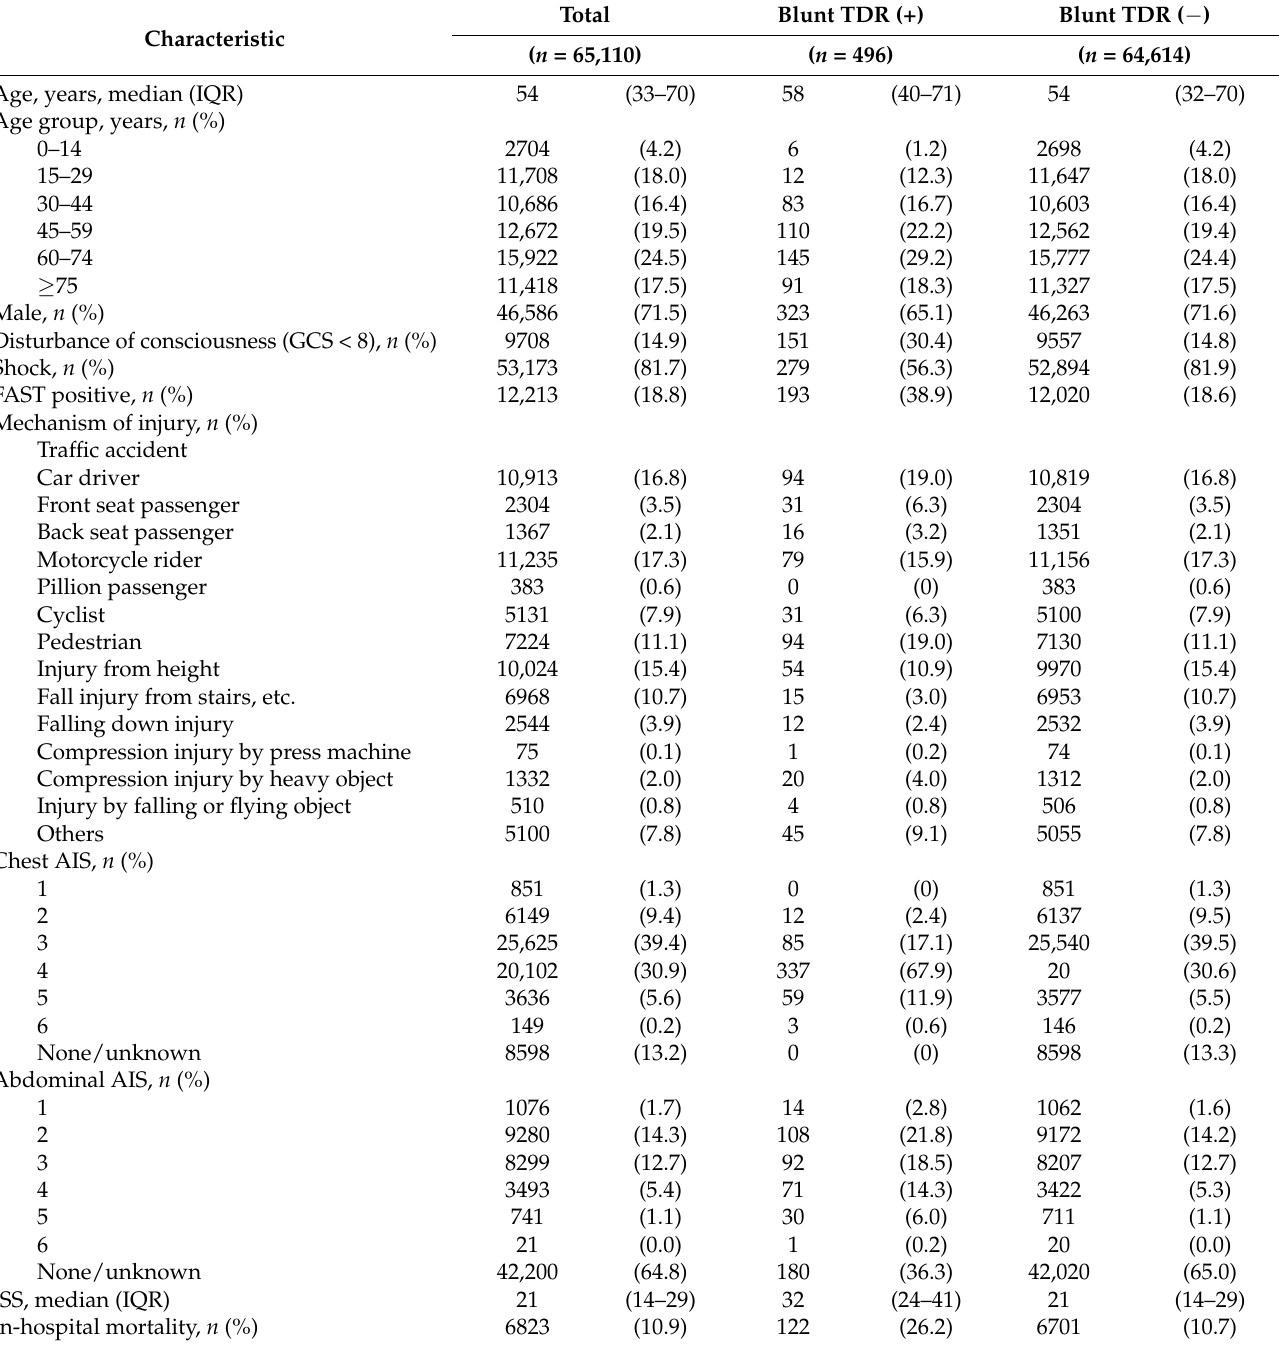
Table 1. Demographic and clinical characteristics of the study patients with chest or abdominal